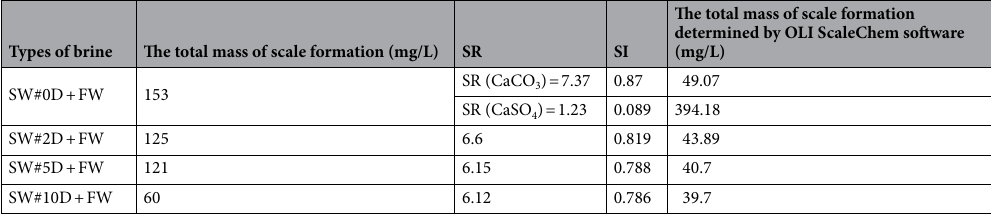
Table 8. The scale mass deposited for each LSW composition at different times diluted